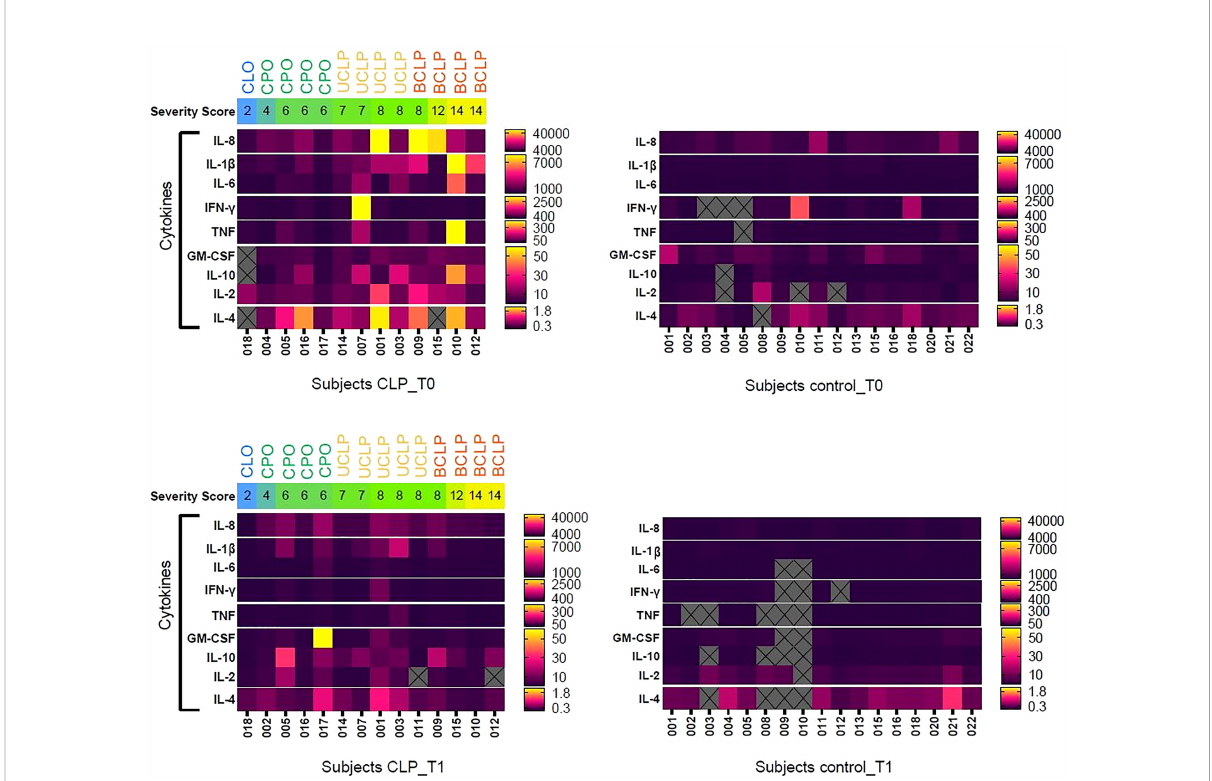
FIGURE 3 Heat map representing the cytokine concentrations (pg/ml) of measured cytokines (Granulocyte-macrophage colony-stimulating factor = GM- CSF, Interferon gamma = INF-y, Tumor-necrosis-factor = TNF, Interleukin (IL)-1ß/-2/-4/-6/-8/-10) for each subject in the cleft patients (CLP) group compared to the control (Ctrl) group at both time points (T0 = after birth, T1 = 4-5 weeks after birth). The subjects in the CLP group are organized left to right from the lowest severity score (severity score 2) to the higher (severity score 14). The severity score and the cleft type for each individual subject are ordered horizontally for each patient and are represented by color scheme: severity score is given by a color gradient from low (blue) to medium (green) to highest (yellow) cleft severity; cleft phenotype is given above: Cleft lip only (CLo) =blue letters, Cleft palate only (CPo) = green letters, unilateral cleft lip palate (UCLP) = yellow letters, bilateral cleft lip palate (BCLP) = orange letters. The red line represents the cut-off between low and high severity score. The range of concentration for each cytokine (pg/ml) is given on the right side and the measured cytokines are organized vertically from highest to lowest concentration. A double gradient map represents the levels of cytokines for each subject (yellow = highest concentration, pink = intermediate concentration, dark violet = lowest concentration). The gray squares with X are excluded multiplex-cytokine measurements due to concentrations below the detection